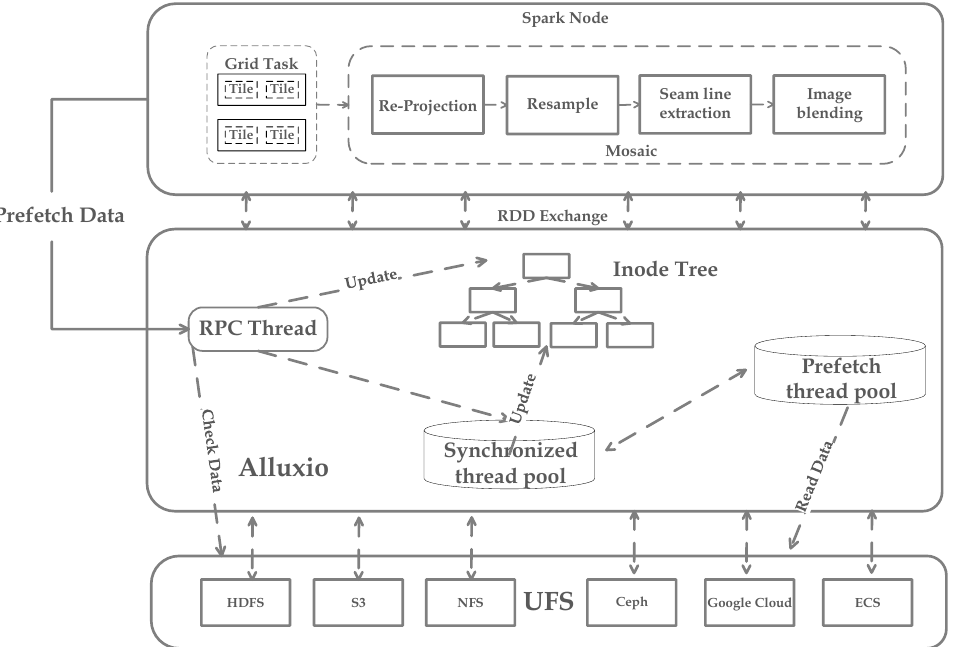
Figure 3. The RPC thread reads the image information, updates the InodeTree information in Alluxio, and synchronizes the remote sensing images in Alluxio with the underlying file system. Alluxio submits the synchronized information to the synchronization thread pool, while the prefetch thread pool is responsible for reading remote sensing image information from the underlying file